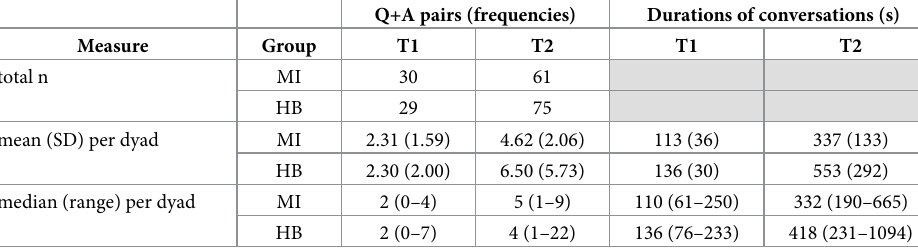
Table 2. Descriptive statistics for the spontaneous Q+A pairs produced by MI and HB groups in the final dataset, in T1 and T2